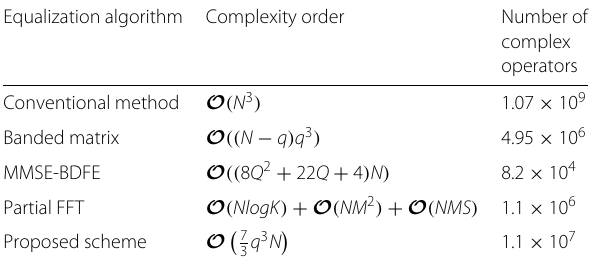
Table 5 Comparison of complexity order Equalization algorithm Complexity order